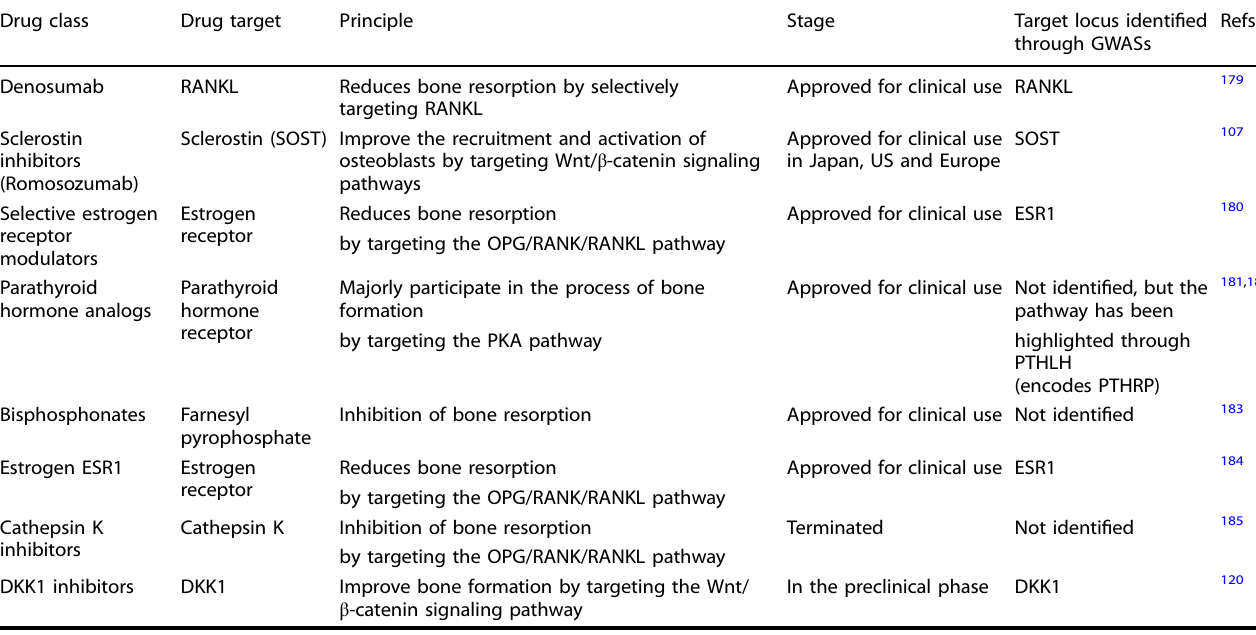
Table 3. Present and potential near-term osteoporosis drug targets that have been linked to changes in BMD by GWAS. Table adapted from